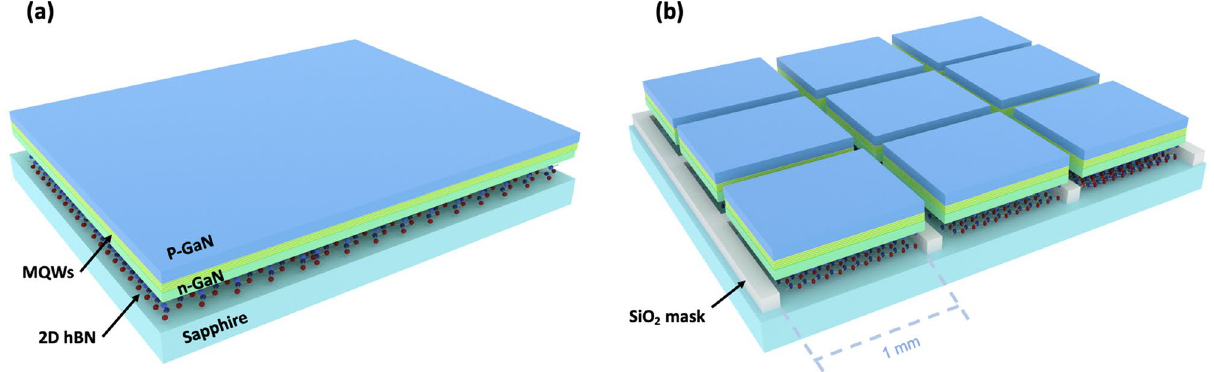
Figure 1. Schematics of the two grown structures: ( a ) LEDs on h-BN/unpatterned sapphire, ( b ) LEDs on h-BN/ patterned sapphire with SiO 2